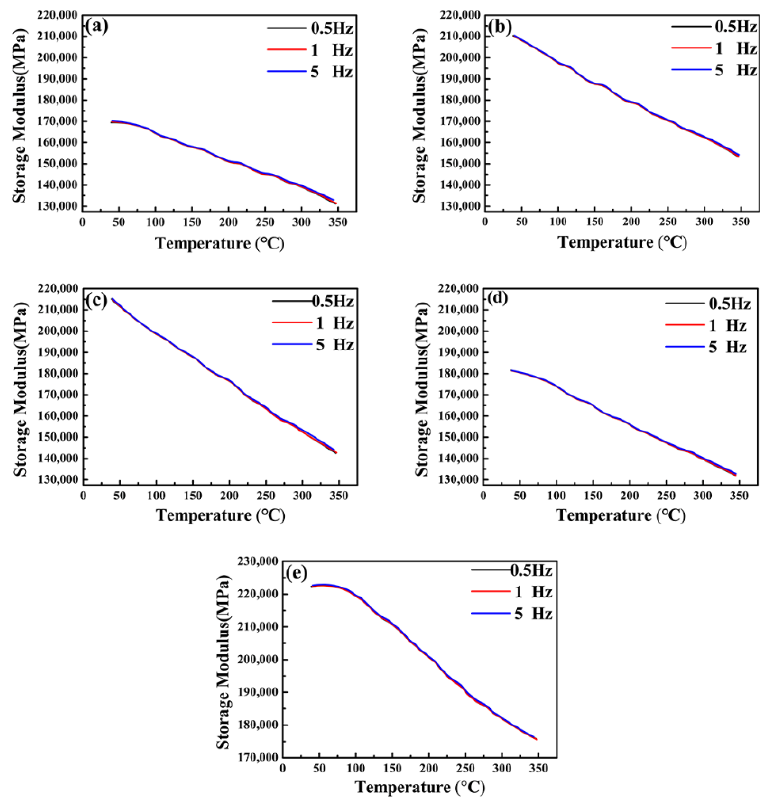
Figure 7. Storage modulus of the SiC ceramic infiltrated by Al alloy with different Si content: ( a ) 5 wt. %, ( b ) 10 wt. %, ( c ) 15 wt. %, ( d ) 20 wt. % and ( e ) initial SiC ceramic.